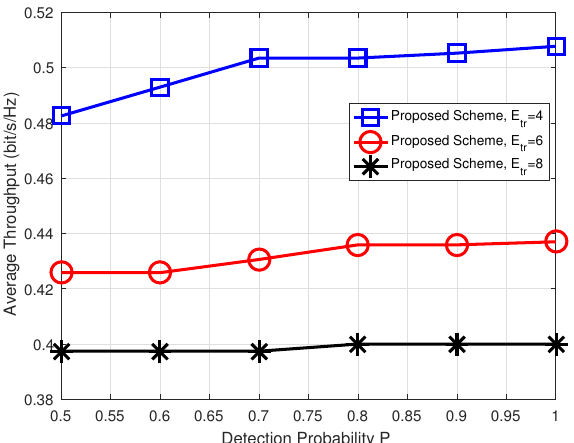
Figure 8. Average throughput versus detection probability P d when transmission energy E tr = 4,6, and